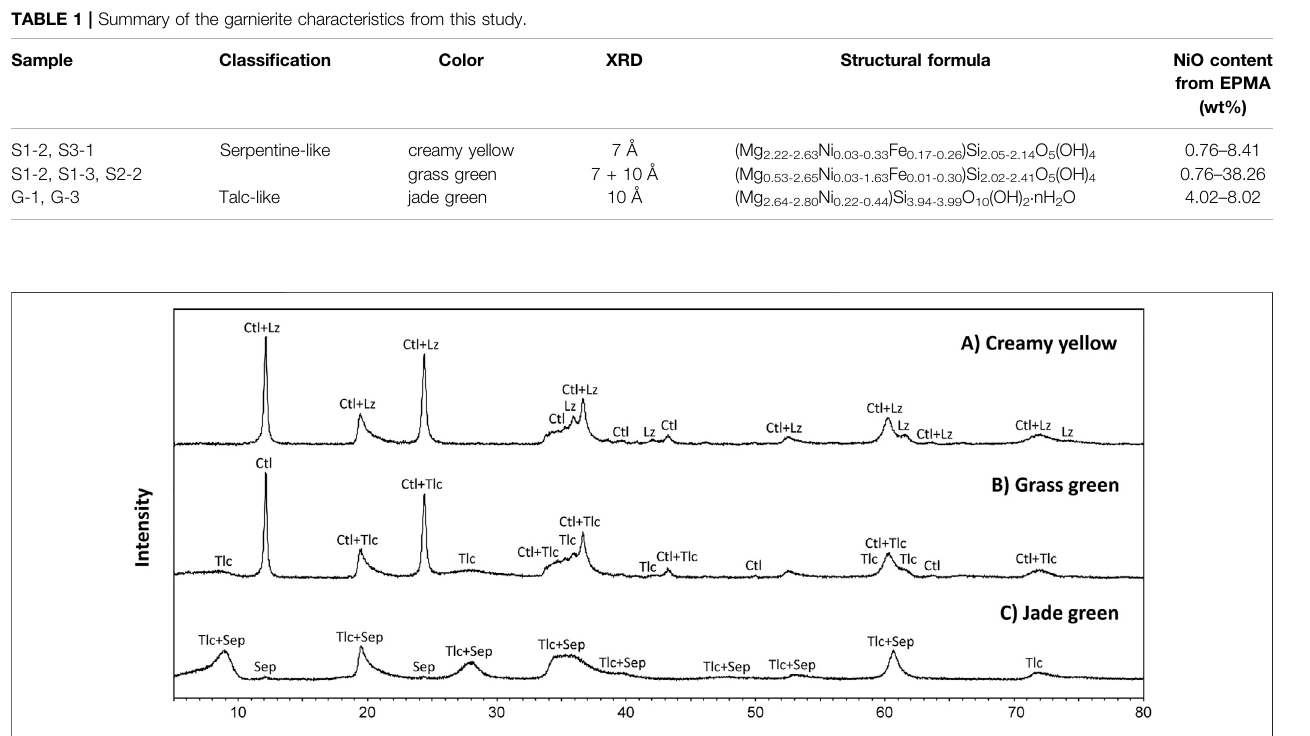
Frontiers in Earth Science |